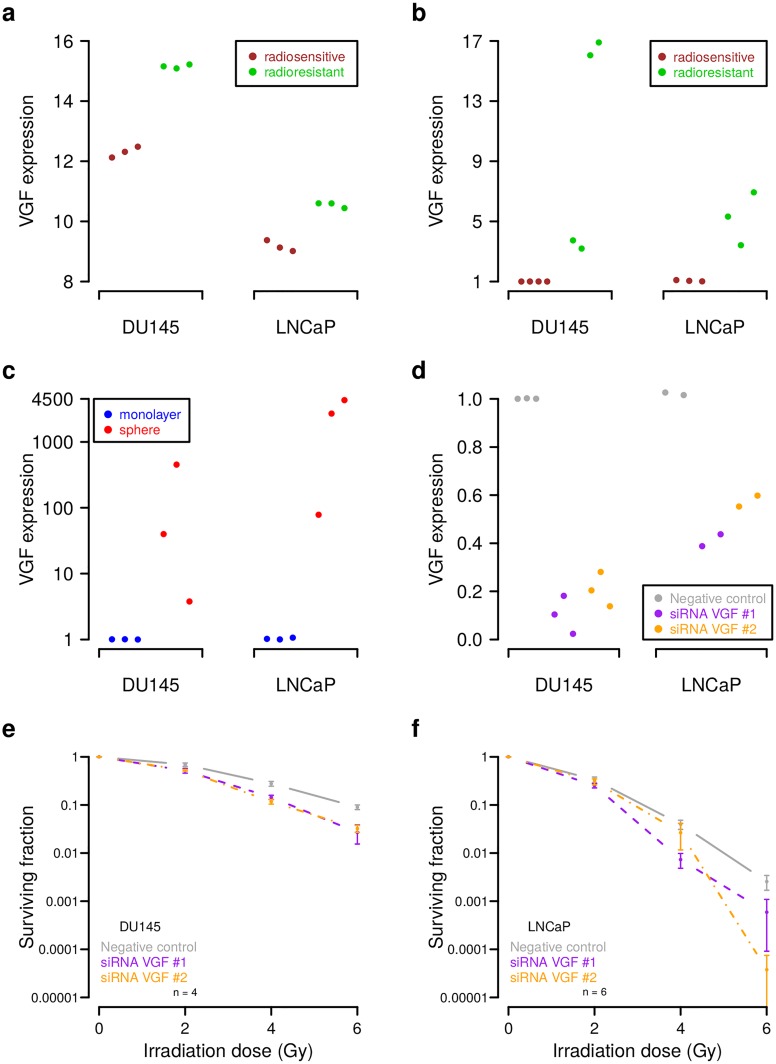
Experimental validation of VGF as regulator of cell radioresistance.(a) Increased VGF expression in radioresistant DU145 and LNCaP in comparison to their radiosensitive parental cell lines in our microarray data. Three biological replicates were considered for each condition. (b-d) RT-qPCR analysis of VGF expression under different conditions. (b) Increased VGF expression in four independent radioresistant DU145 and three independent radioresistant LNCaP clones relative to their radiosensitive parental cell lines. (c) Increased VGF expression in sphere relative to monolayer cultures of parental DU145 and LNCaP cells. (d) Reduced VGF expression in parental DU145 and LNCaP cells induced by siRNA-mediated gene silencing relative to negative controls. (e-f) Increased radiosensitivity of parental DU145 and LNCaP cells induced by siRNA mediated reduction of VGF expression. Shown are average fractions of surviving cells in log10-scale for increasing radiation dose. Error bars represent the standard error of the mean and ‘n’ specifies the number of biological replicates. Corresponding linear-quadratic (LQ) model curves are shown in S11 Fig.